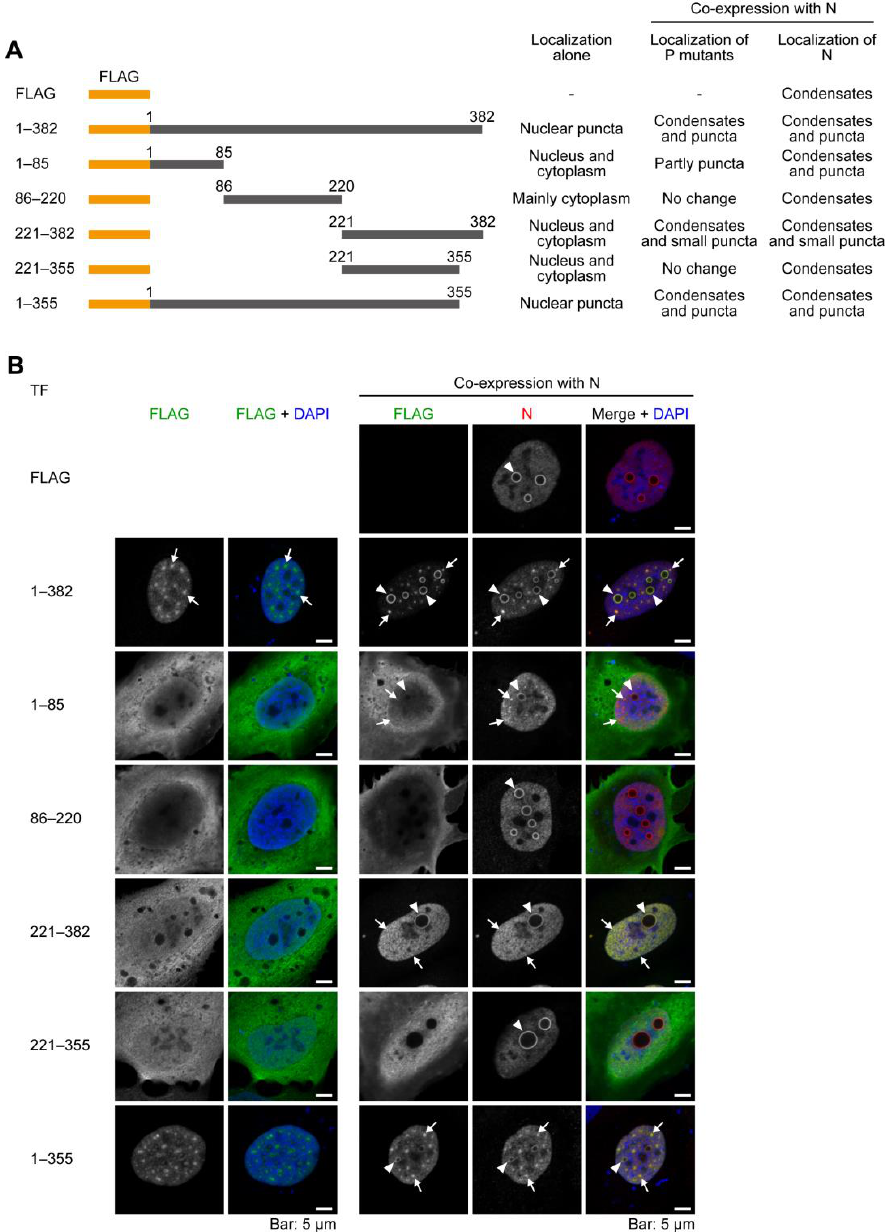
Figure 2. Subcellular localizations of a series of deletion mutants of NYMV P. ( A ) A schematic diagram of a series of deletion mutants of P used in this experiment and the summary of the localizations of P mutants and N when co-expressed with P mutants. Numbers 1–382 represents the full-length P. ( B ) The localizations of a series of deletion mutants of P in uninfected U-2 OS cells in the case of P mutants alone (left column) or when co-expressed with N (right column). Arrowheads and arrows indicate condensates and puncta, respectively. The presented confocal microscopic images were the images of single focal planes.